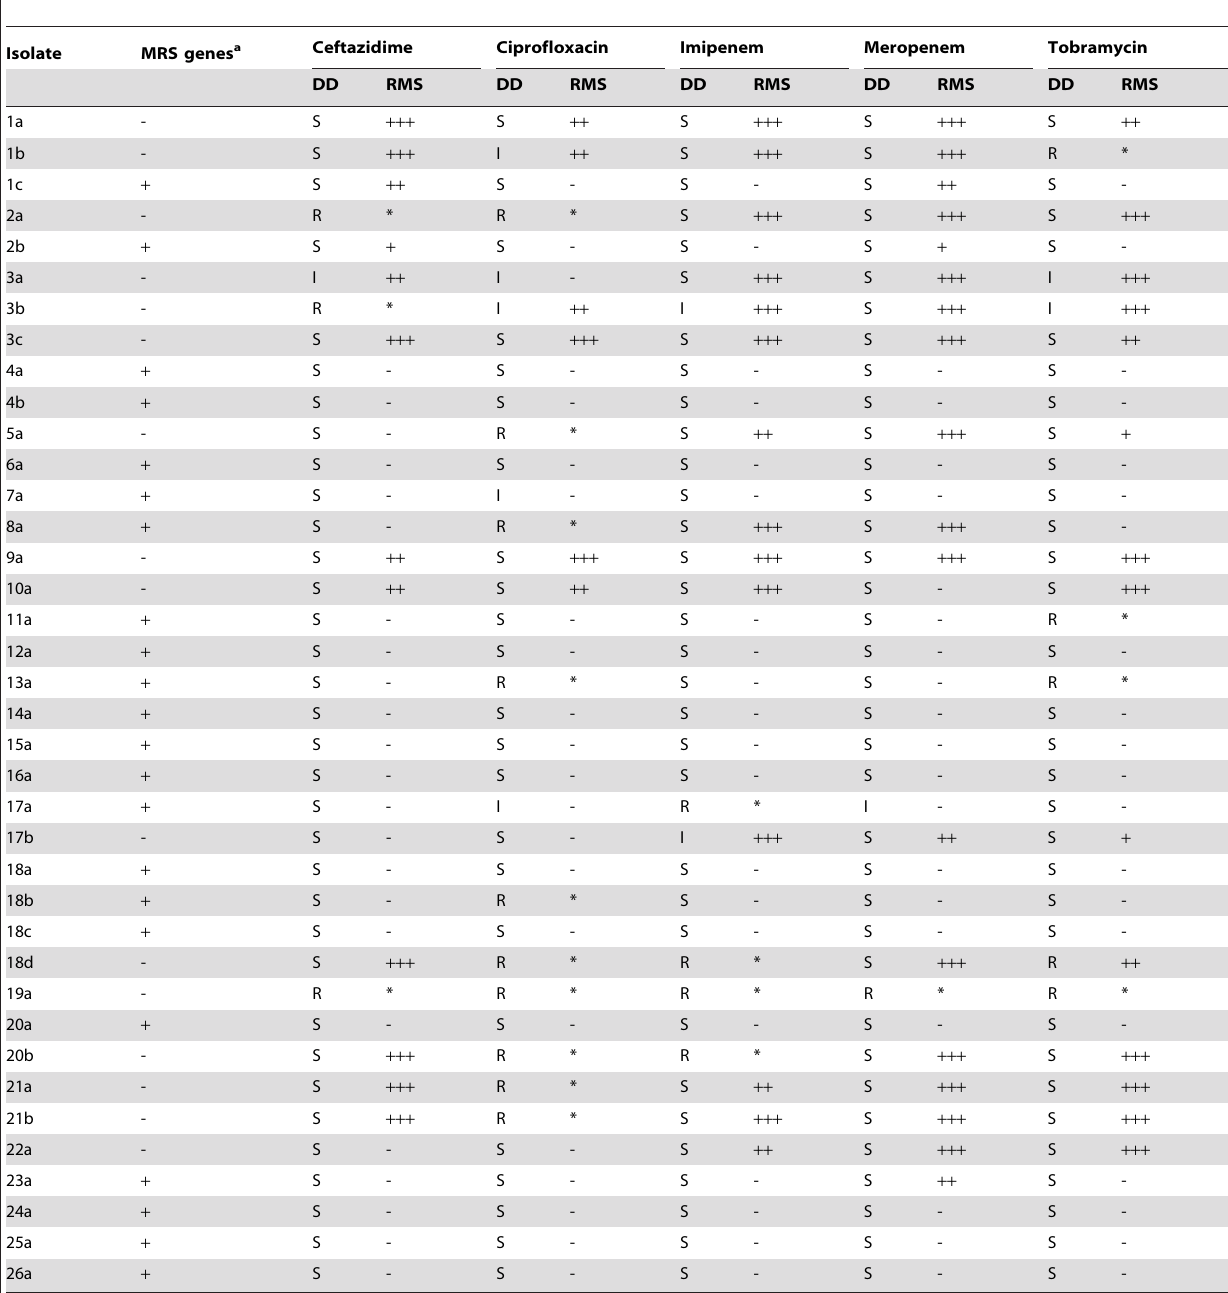
Table 3. Antibiotic disk diffusion test and quantification of the resistant mutant subpopulations of the 38 P. aeruginosa CF isolates